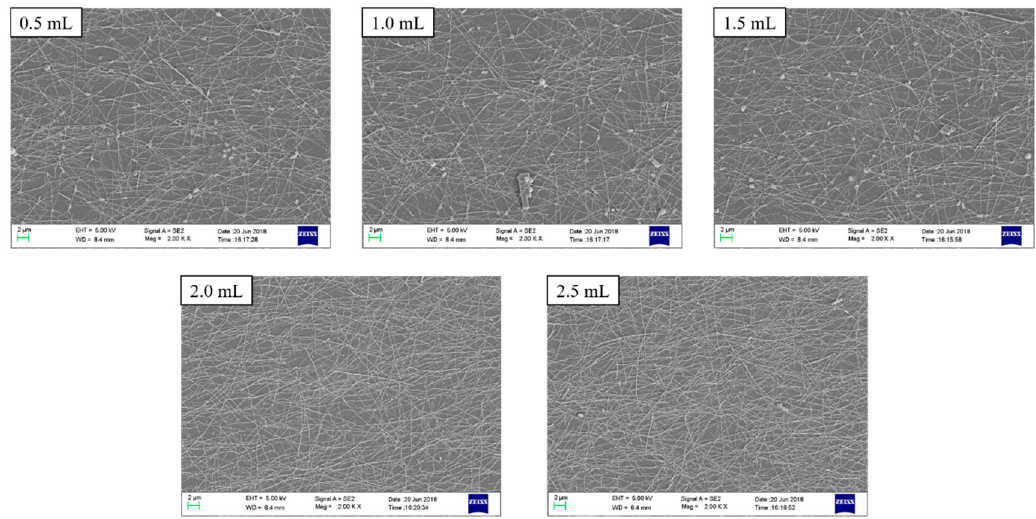
Figure 4. SEM images of the printed AgNWs patterns with different amounts of silver nanowires ink.